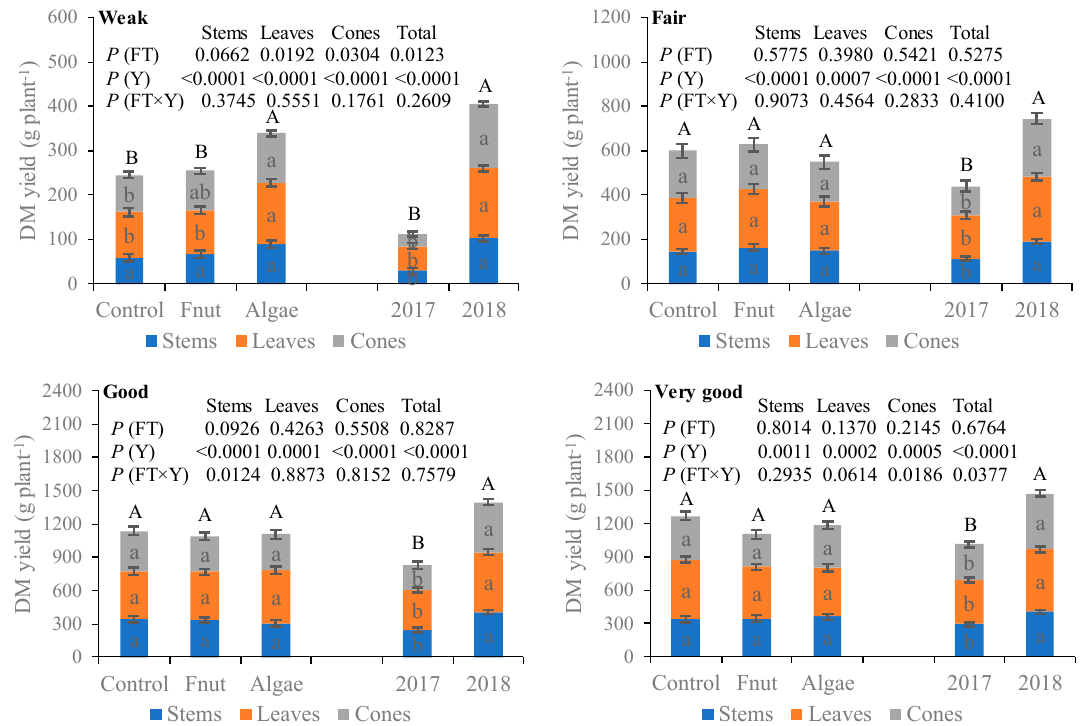
Figure 2. Dry matter (DM) yield of hop plant parts (average ± standard error) in the different plant vigour plots (Weak Fair, Good and Very good), as a function of foliar treatment (Fnut, nutrient-rich foliar spray; Algae, algae-rich foliar spray; and Control) and year. Within each plant part (lowercase letters) or total DM yield (uppercase letters), means followed by the same letter are not statistically different ( α = 0.05) by Tukey HSD test (Foliar treatment) or Student’s t-test (Year).